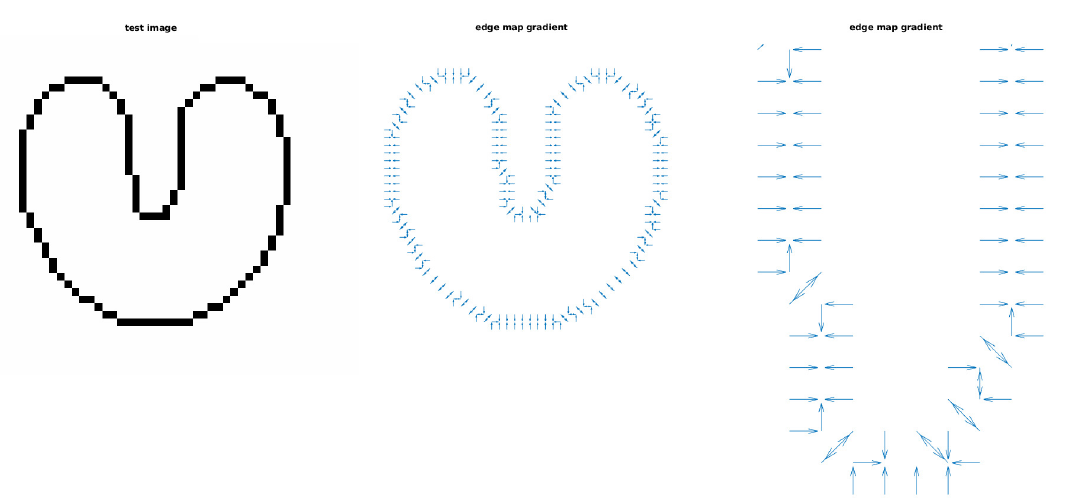
Figure 6. Example of Gradient vector field of a U shape object. ( Left ) Original image. ( Center ) Gradient of the object. ( Right ) Zoom of the vector field in the central concavity of the